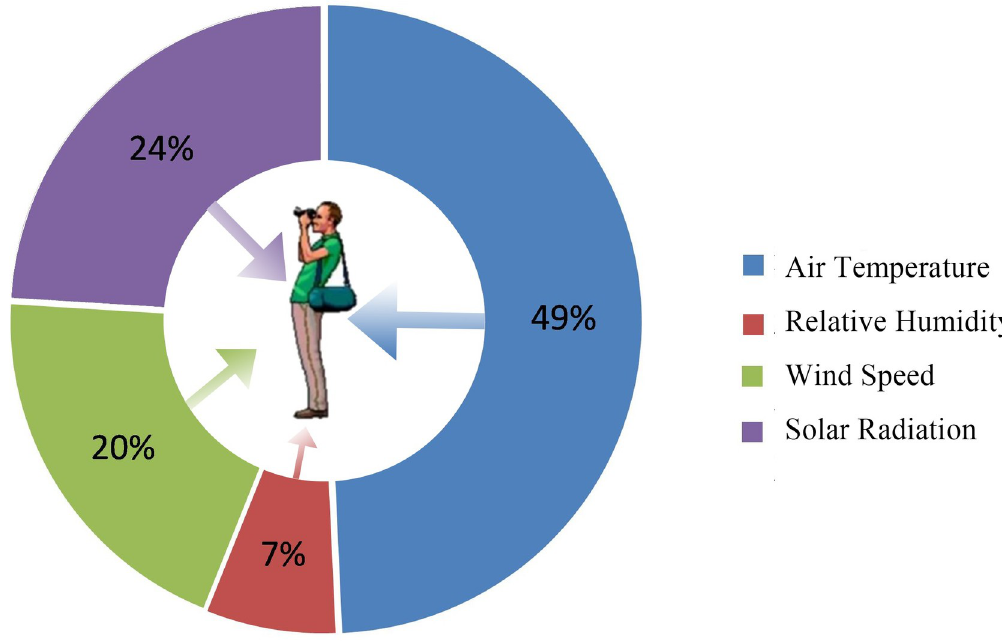
Fig 7. Evaluation of the influence of certain characteristics on subjective